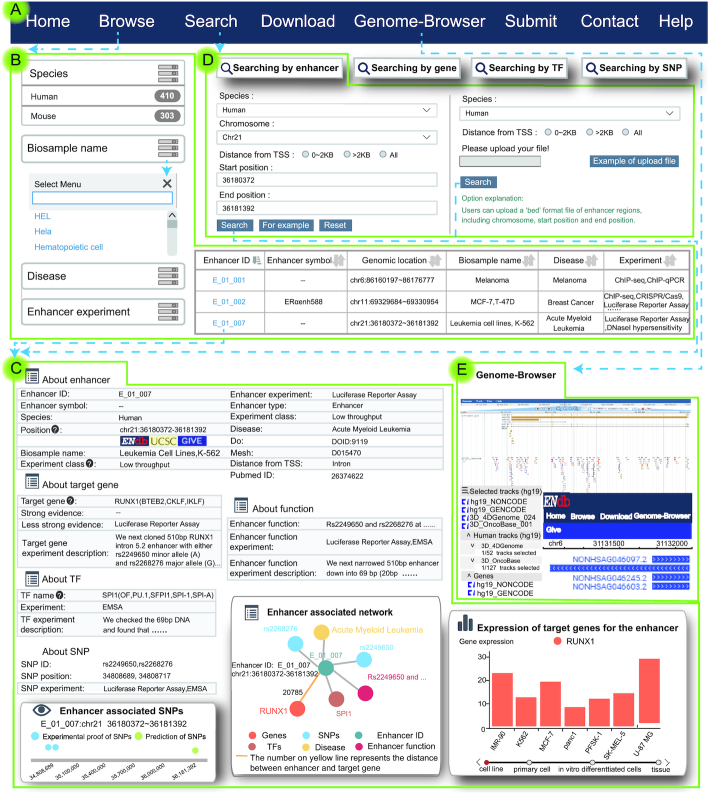
Database content and construction. (A) ENdb provides a user-friendly interface to browse, search, download, submit and visualize detailed information about enhancers. (B) The ‘Browse’ page allows users to quickly browse the information of enhancer and provides fuzzy search functions according to different conditions. (C) The ‘Detail’ page provides the general information of enhancer and the enhancer-associated information. The enhancer-associated information is graphically displayed in the page. (D) The ‘Search’ page allows users to search by a variety of keywords to return the records via four paths. Users also search the information of enhancers via the official symbols or aliases of genes. (E) Users view the proximity information of enhancers in the genome in the ‘Genome-Browse’ page.